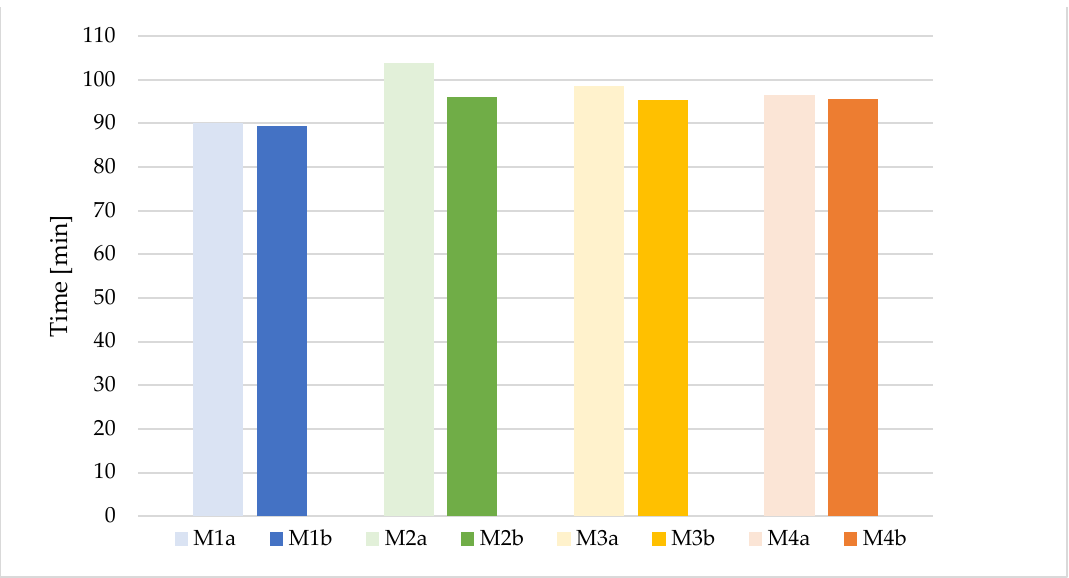
Figure 14. Charging time, which is the total time of the phase change process for all models and working fluid velocity magnitudes.